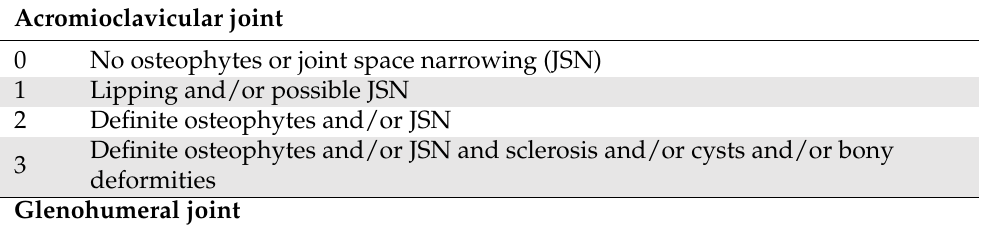
Table 1. Definition of OACT scores for individual